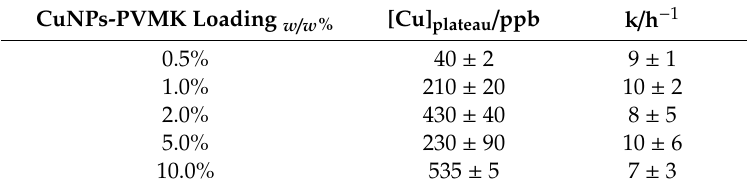
Table 3. Plateau values and kinetic constants for copper release from CuNPs-PVMK composite films prepared at di ff erent copper loading. Data obtained after interpolation according to a first order kinetic trend. The values were averaged out of three replicates ± 1S (one standard